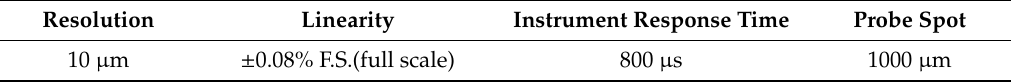
Figure 1. Real time detection of deformation behavior during thin-wall sample deposition: ( a ) schematic diagram of detection system, ( b ) principle schematic of laser displacement sensor. Table 1. The performance parameters of the laser displacement